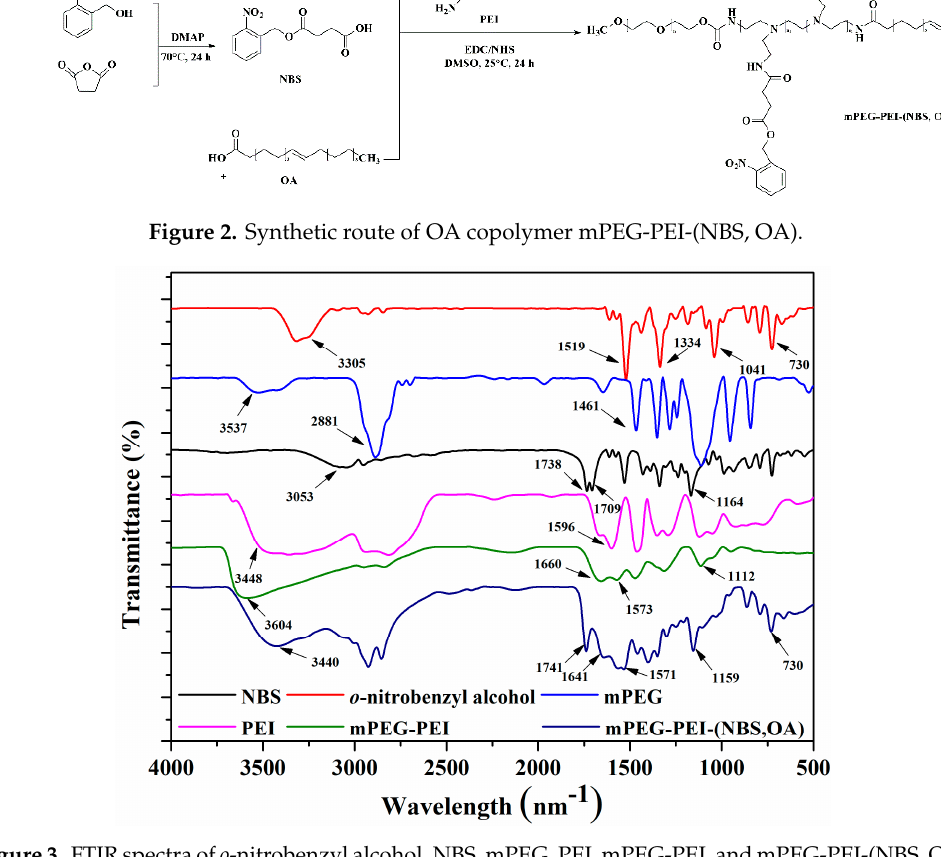
Figure 3. FTIR spectra of o -nitrobenzyl alcohol, NBS, mPEG, PEI, mPEG-PEI, and mPEG-PEI-(NBS, OA).